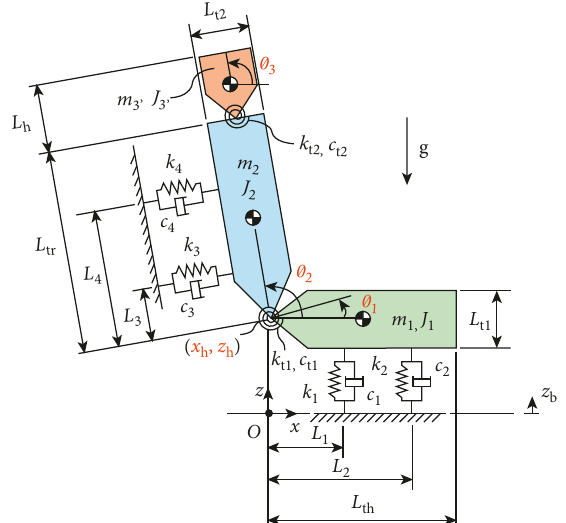
Figure 2: Directional definition of the translational spring deflections.